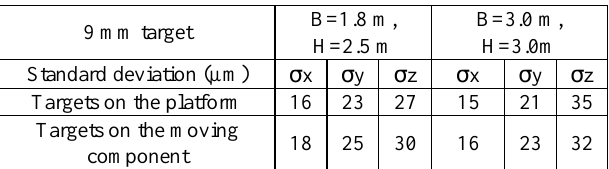
Table 6: Standard deviations of 9 mm targets based on different structural conditions.